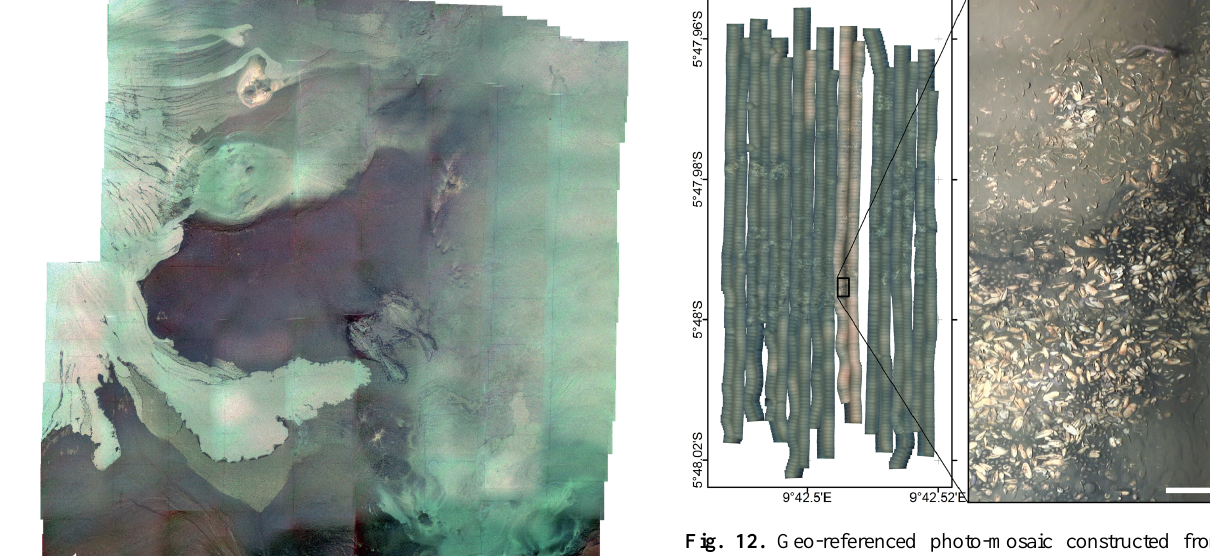
Fig. 12. Geo-referenced photo-mosaic constructed from high- definition video material of the Regab pockmark (Lower Congo basin); it shows clam aggregations in dark reduced sediments; the photo-mosaic covers a large area of 5800m 2 with a resolution which allows for the ability to distinguish individual living and dead